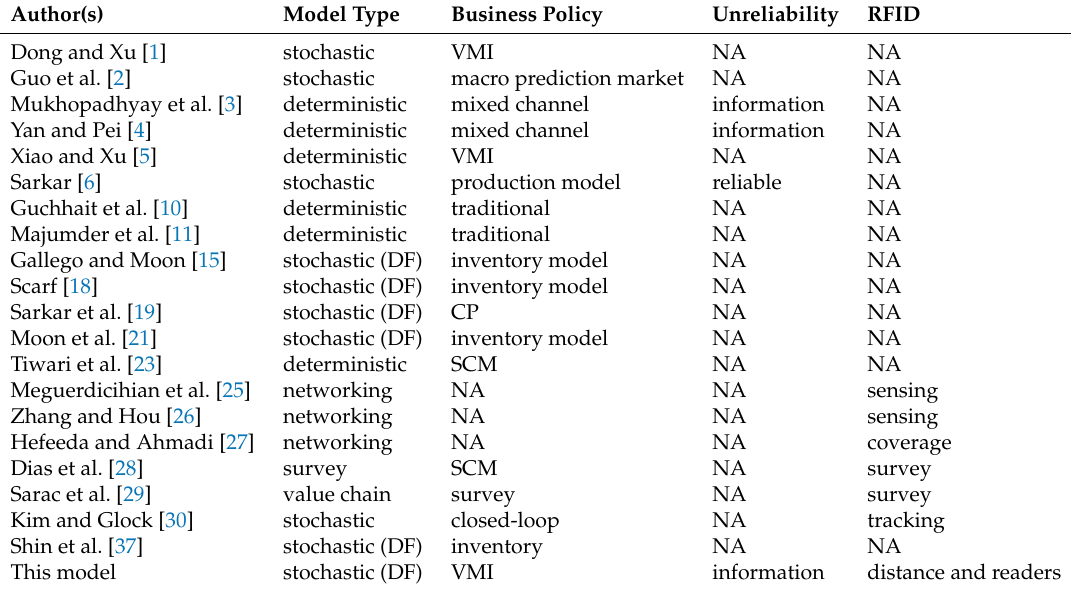
Table 1. Comparison of author’s